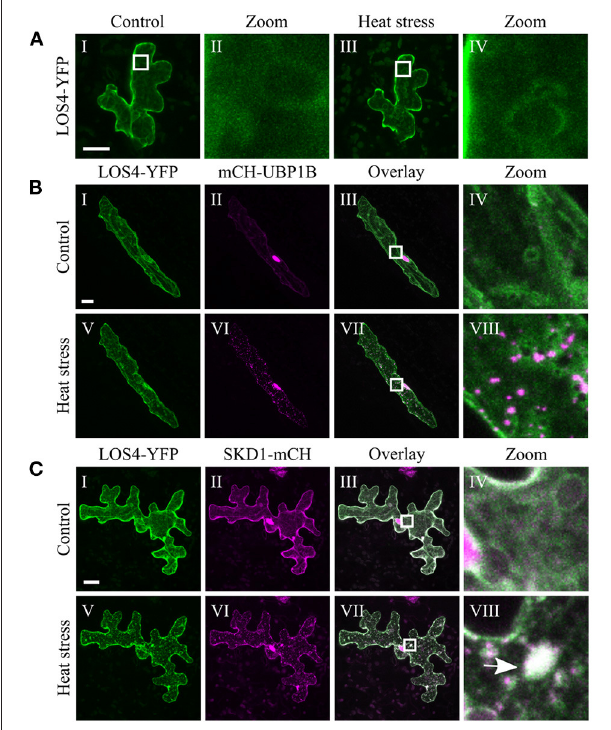
FIGURE 8 | Subcellular localization of LOS4 before and after heat stress. Representative images of CLSM stacks (maximum projections) of leaf epidermal cells single or double transformed with constructs overexpressing ( 35S promoter) LOS4. The results are summarized in Table 3 . The same cells were imaged before and after heat stress. Co-localizing structures are indicated by arrow heads. Scale bar = 20 µ m. LOS4-YFP (A) alone, (B) with mCH-UBP1B, (C) with SKD1-mCH.